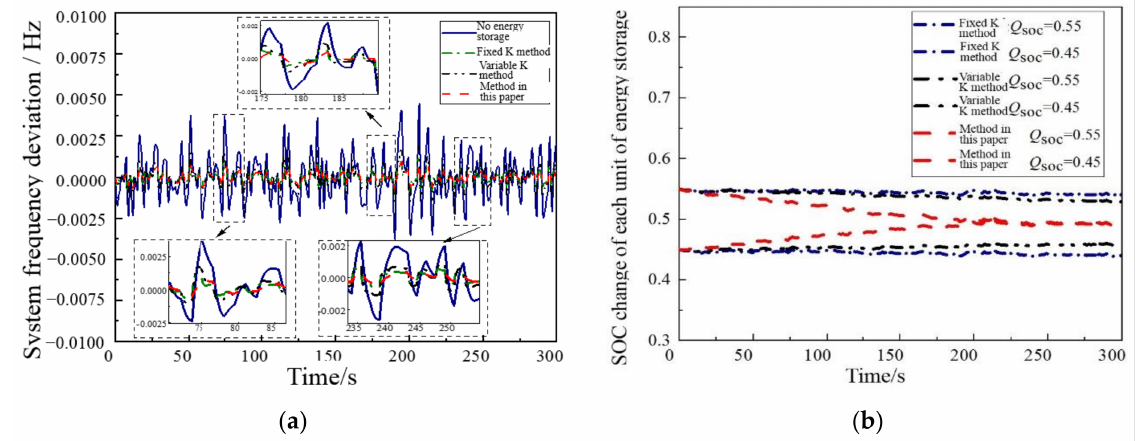
Figure 8. Case 2: response curve of frequency and SOC: ( a ) frequency response curve; ( b ) average SOC change